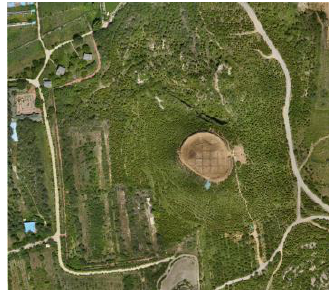
Figure 5. Orthographic image of the ruins area and surrounding